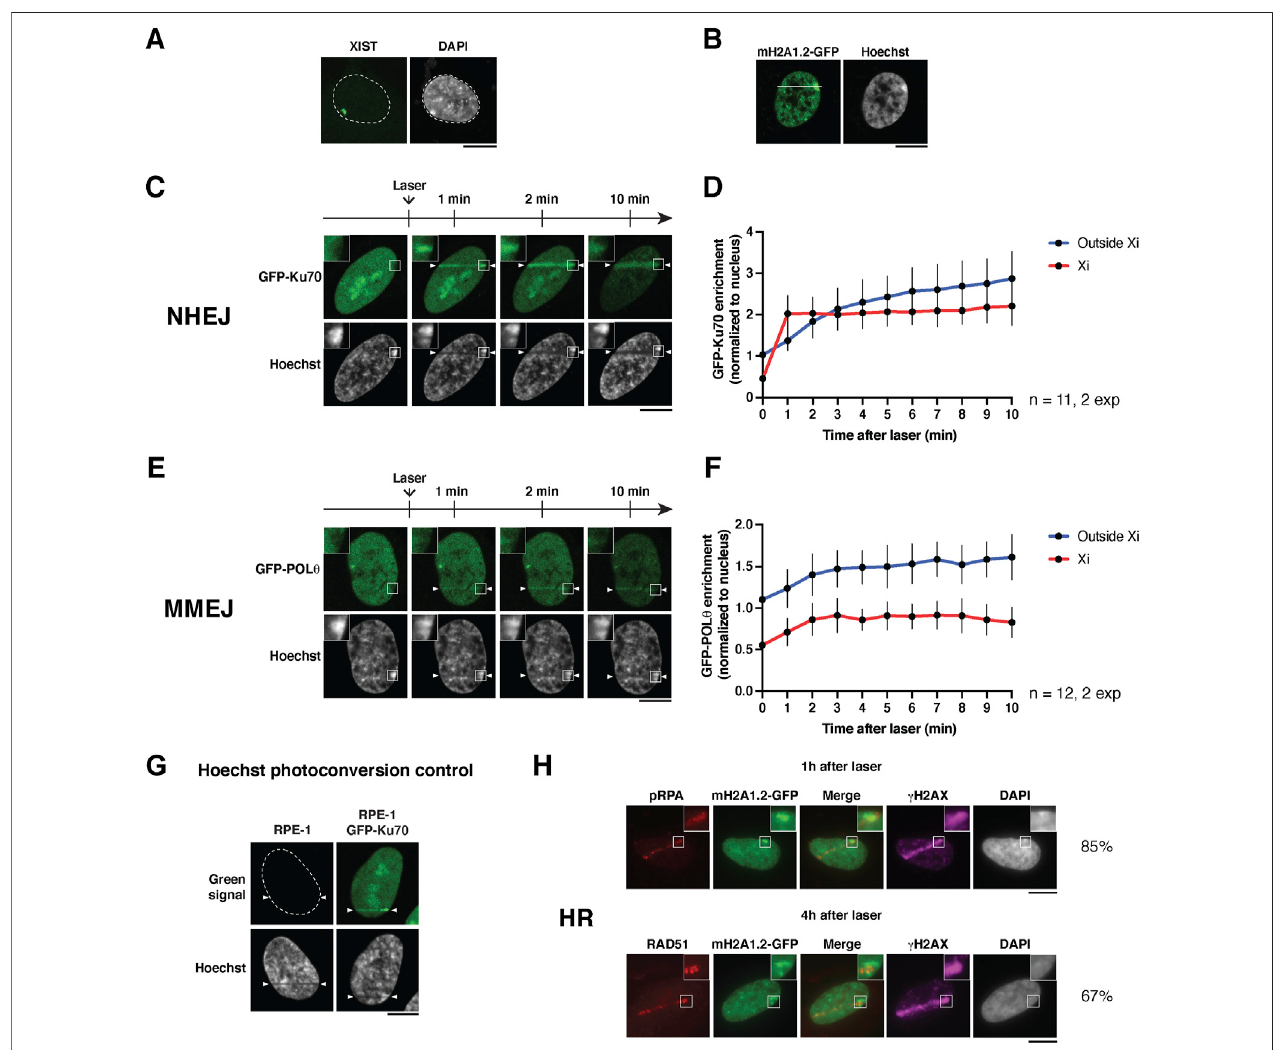
FIGURE 2 | Imaging the recruitment of DSB repair factors to the inactive X chromosome. (A) RNA-FISH staining for XIST RNA on the inactive X chromosome in RPE-1cellsusing themethod described inChaumeilet al.(2008).TheXISTcloud colocalizes withthemostintenseDAPIregioninthenucleus. Themicroscopyimageis amaximumintensity projectionof25z-planes. (B) NucleusofanRPE-1cell stablyexpressing macroH2A1.2-GFPand stainedwithHoechst. Awhitelinedepictshowto position the laser line to damage the Xi. (C,E) Live cell imaging showing the recruitment of the indicated GFP-tagged NHEJ and MMEJ factors to the inactive X chromosome(Xi)following405 nmlasermicro-irradiationinhumanRPE-1cells. (D,F) Quanti fi cationsofthesignalsintheXi(red)andoutsidetheXi(blue)asafunctionof time after laser damage are shown for each repair factor. Data are presented as mean values ± SD from a total of n nuclei scored in two independent experiments. (G) Hoechst photoconversion control after 405 nm micro-irradiation in RPE-1 cells (parental untransfected cell line vs cells expressing GFP-Ku70). Imaging settings were kept the same for both cell types. (H) Recruitment of the indicated HR factors in the inactive X chromosome (Xi) analyzed by immuno fl uorescence, 1 h (pRPA) or 4 h (RAD51) after 405 nm laser micro-irradiation in RPE-1 cells stably expressing GFP-tagged macroH2A1.2 (mH2A1.2-GFP). The percentages indicate the proportion of HR-prone cells (S/G2) that display recruitment of the respective HR factor to the damaged Xi. Antibodies used: primary antibodies anti-phospho-RPA32 Ser4/8 (Bethyl Laboratories A300-245A, 1:1,000), anti-RAD51 (Abcam ab176458, 1:1,000), anti- γ H2A.X (Merck Millipore 05-636, 1:1,000); secondary antibodies anti-rabbit Alexa Fluor 568 (Invitrogen A11036, 1:1,000), anti-mouse Alexa Fluor 647 (Invitrogen A21236, 1:1,000). The position of the laser track is indicated by arrowheads. All microscopy images are confocal sections unless stated otherwise. Scale bars, 10 μ